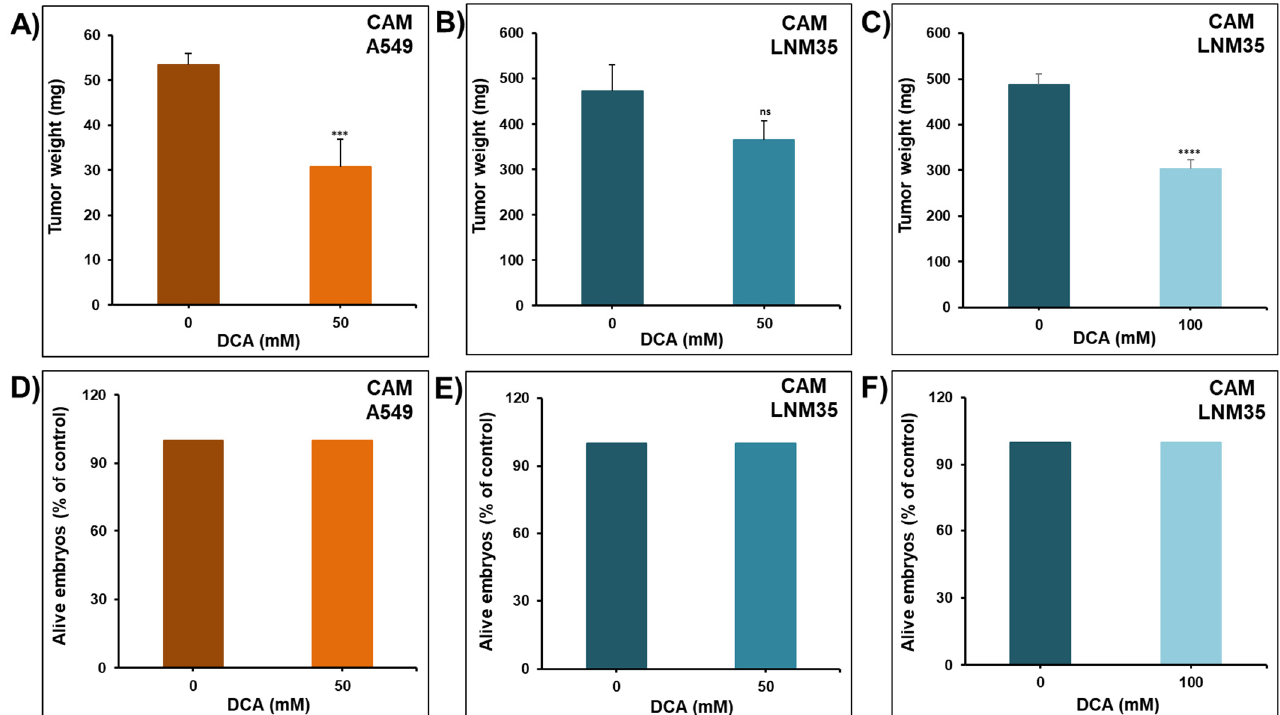
Figure 2. Effect of DCA on the growth of A549 and LNM35 tumor xenografts in the chick embryo CAM in vivo. ( A ) Tumor weight of A549 cancer cells xenografted on the CAM at a density of 1 million cells after treatment with drug vehicle (0.9% NaCl) or DCA (50 mM) for 1 week. ( B , C ) Tumor weight of LNM35 cancer cells xenografted on the CAM at a density of 0.3 million cells after treatment with drug vehicle (0.9% NaCl) or DCA (50 mM and 100 mM). ( D ) Percentage of alive embryos in the control and DCA-treated A549 xenografts. ( E , F ) Percentage of alive embryos in the control and DCA-treated LNM35 xenografts. Columns are means; bars are S.E.M. *** Significantly different at <0.001. **** Significantly different at <0.0001. ns—non-significant.